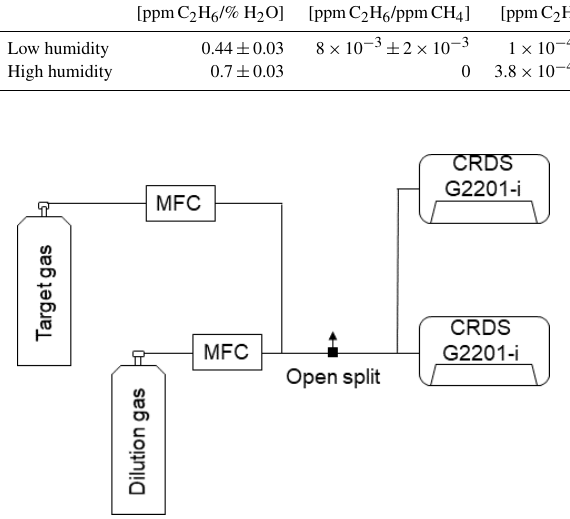
Figure 2. Experimental setup used during laboratory